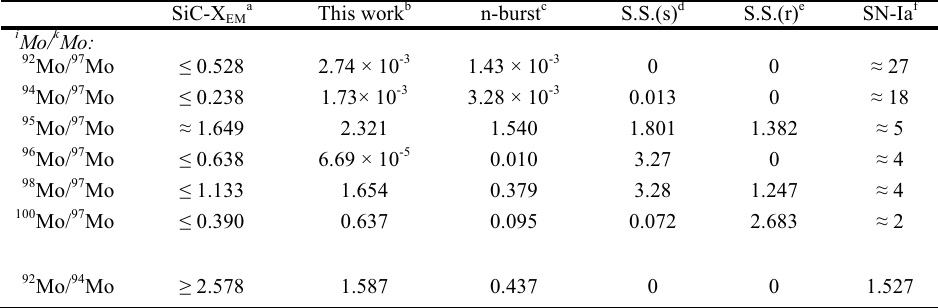
TABLE 1: Mo isotope compositions of SiC-X end-member and various nucleosynthetic processes. SiC-X EMa This work